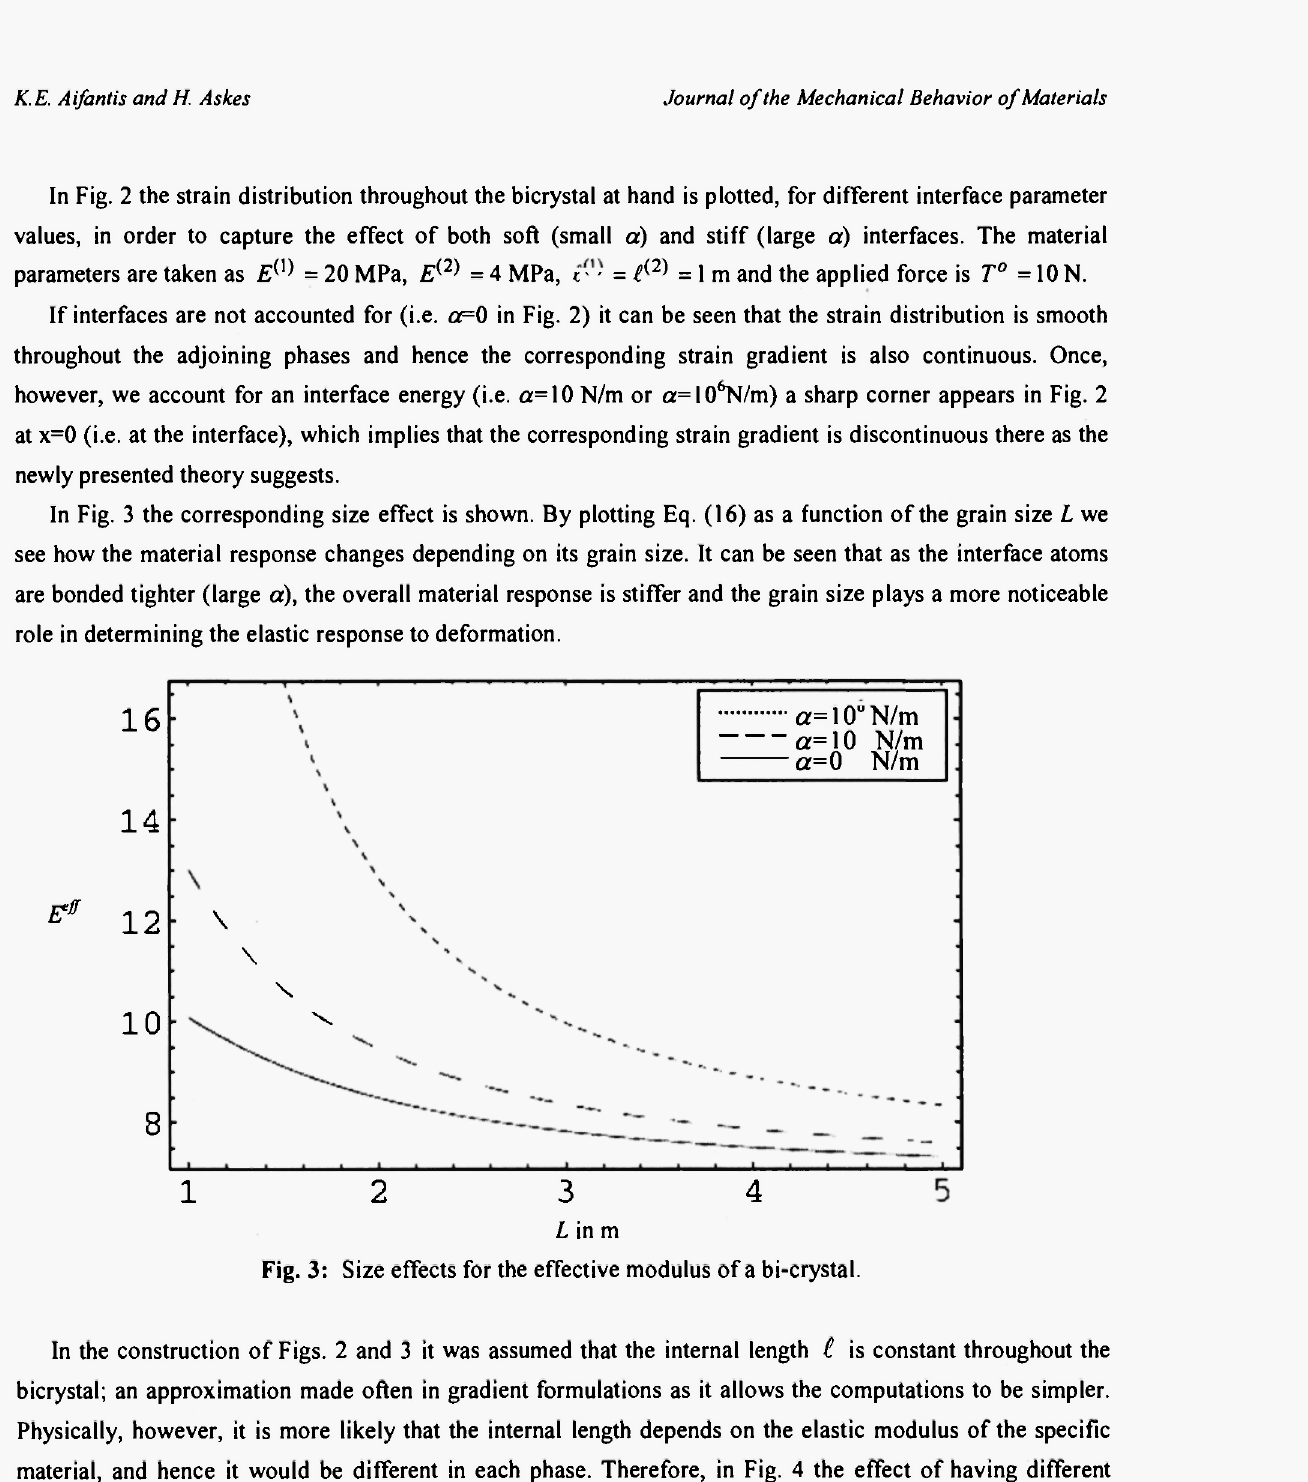
Fig. 3: Size effects for the effective modulus of a